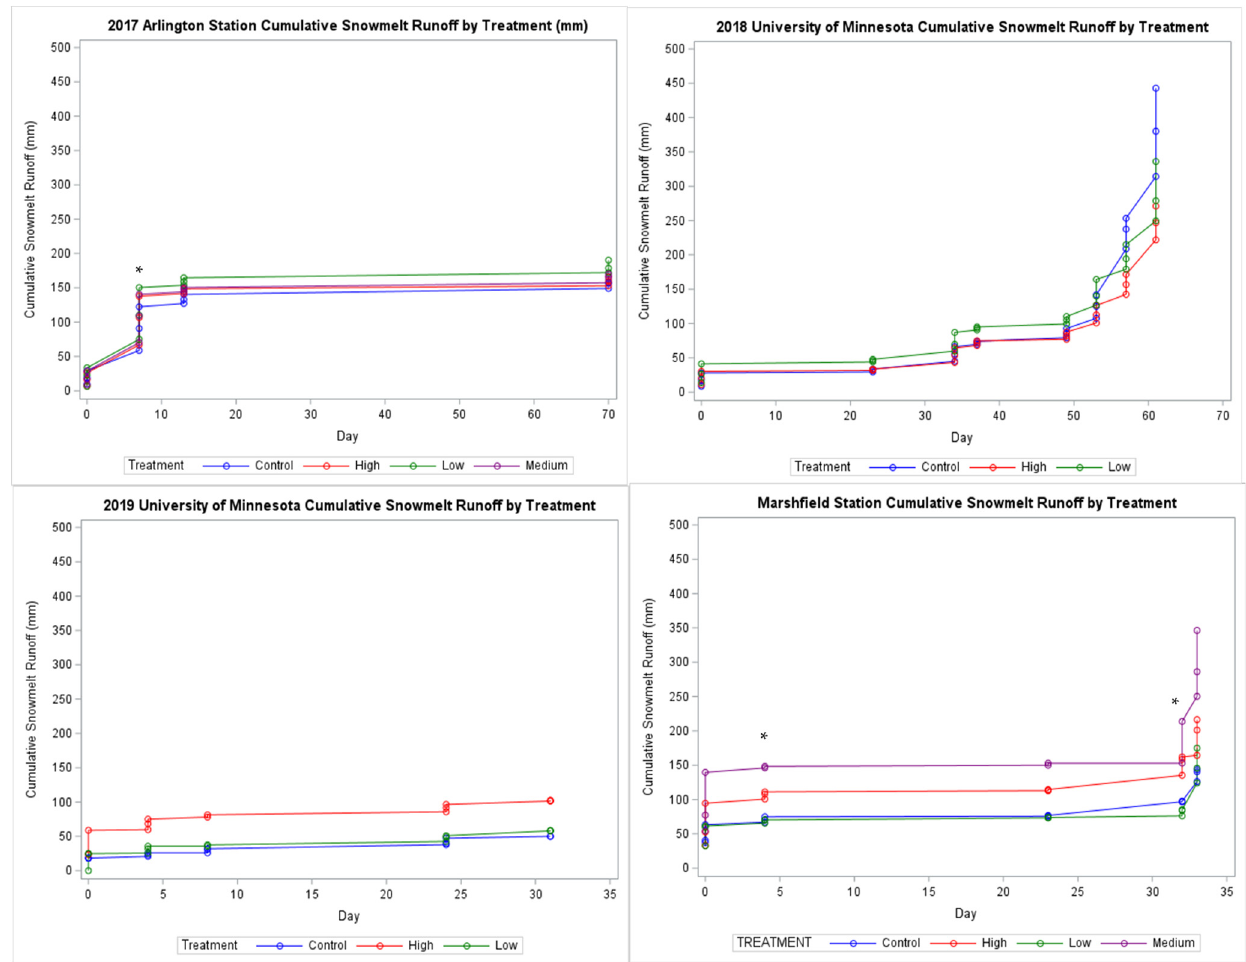
Figure 2 . Cumulative snowmelt runoff by treatments for each site and year of the experiment. Asterisks indicate a significant ( p ≤ 0.05) main effect of manure solids content on snowmelt runoff. The trial was conducted at the Marshfield Station for one year only in 2019.